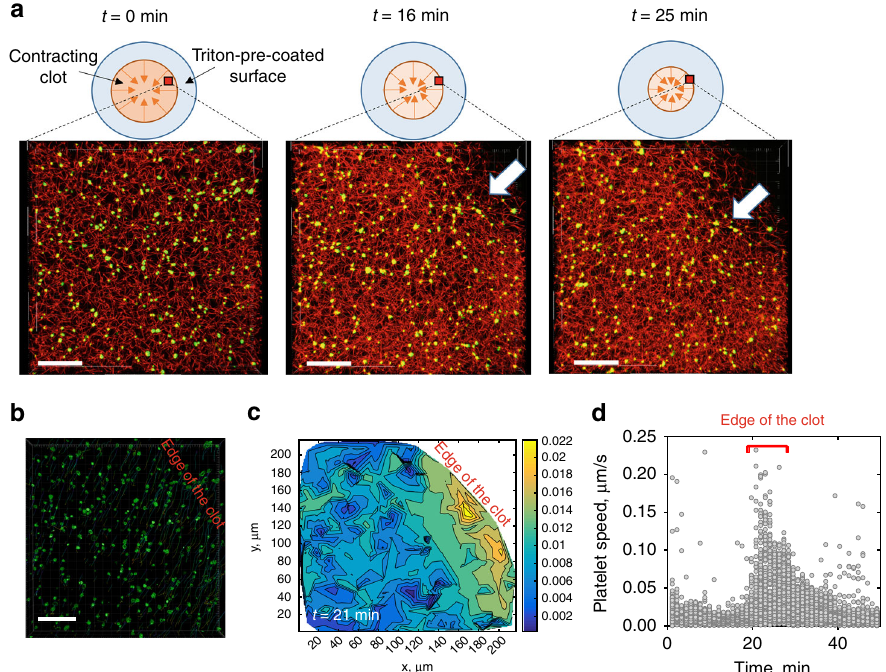
Fig. 6 Non-uniform deformation of platelet- fi brin meshwork during clot contraction. Clots were formed on a Triton X-100 pre-coated surface to allow for unconstrained contraction of the clot edges in both vertical and horizontal directions. a Platelet- fi brin mesh z -projections are shown for three different time points during clot contraction and reveal inward movement of the clot edge ( white arrow ); scale bar : 40 μ m. b Three-dimensional (3D) tracking of individual platelets embedded into the fi brin network allow visualization of the 3D platelet displacement fi eld; Scale bar : 40 μ m. c A representative contour plot of the mean platelet speed inside a clot (20 µ m from the bottom ) based on the reconstituted 3D platelet displacement fi eld. The color bar shows the mean speed of platelet displacement ( µ m/s). d Changes of the platelet moving speed with time during clot contraction, indicating higher speed values at the edge of contracting clots (310 cells in three clots). Data presented in d show the absolute velocity of platelets identi fi ed in the temporal sequence of 3D images shown in a . For each time point in d , a set of data points shown corresponds to velocities of platelets tracked in a 3D volume of contracted clot provided in a . As the edge of the clot passes through the view area between 20 and 30 min time points, platelets reach their high velocity values corresponding to a yellow region in the velocity contour plot in c . For the entire sequence of events see Supplementary Movies 7 −